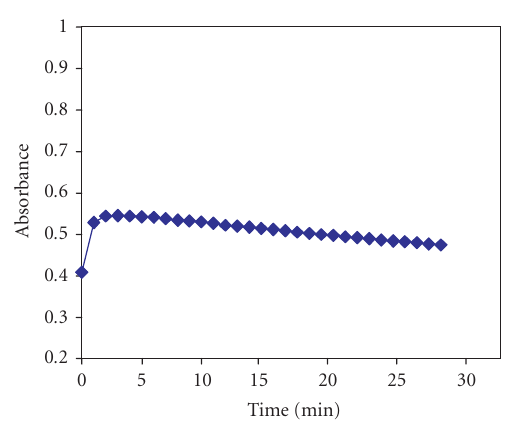
Figure 6. E ff ect of time on the absorbance of LD-iodine com- pound, at pH = 5 and at wavelength = 500nm.